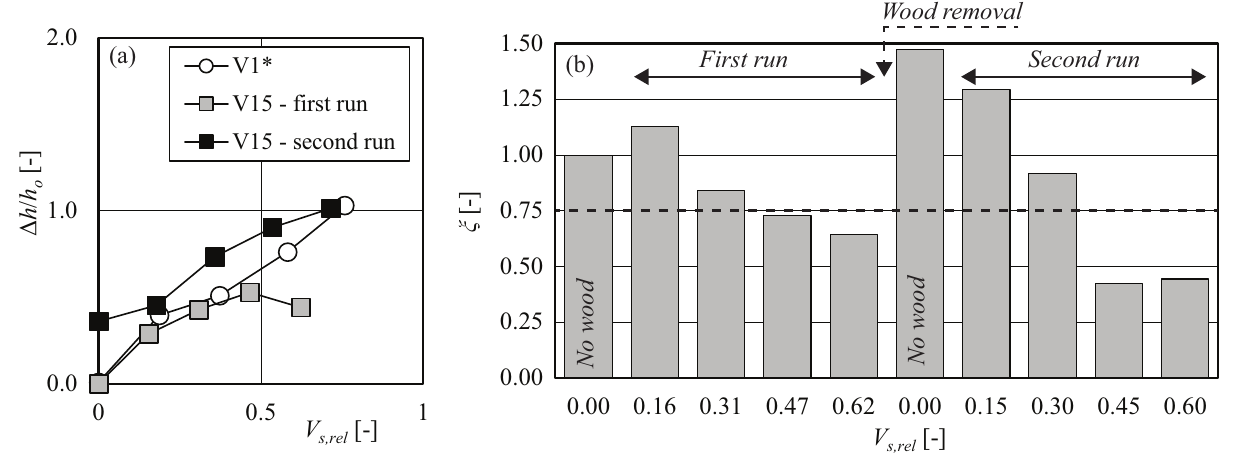
Figure 13. ( a ) Relative backwater rise ∆ h / h o versus V s , rel for test V1* (addition of 4 LW packages; white circles), V15 with first run (wood supply 1: addition of 4 LW packages; gray squares), and V15 with second run (wood supply 2: LW removal from first run and then re-addition of 4 LW packages; black squares); ( b ) bedload transport reduction factor ξ versus V s , rel for test V15 (first and second run).